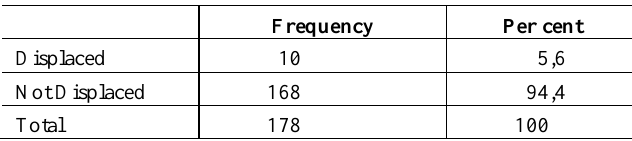
Table 2: Loss of job due to